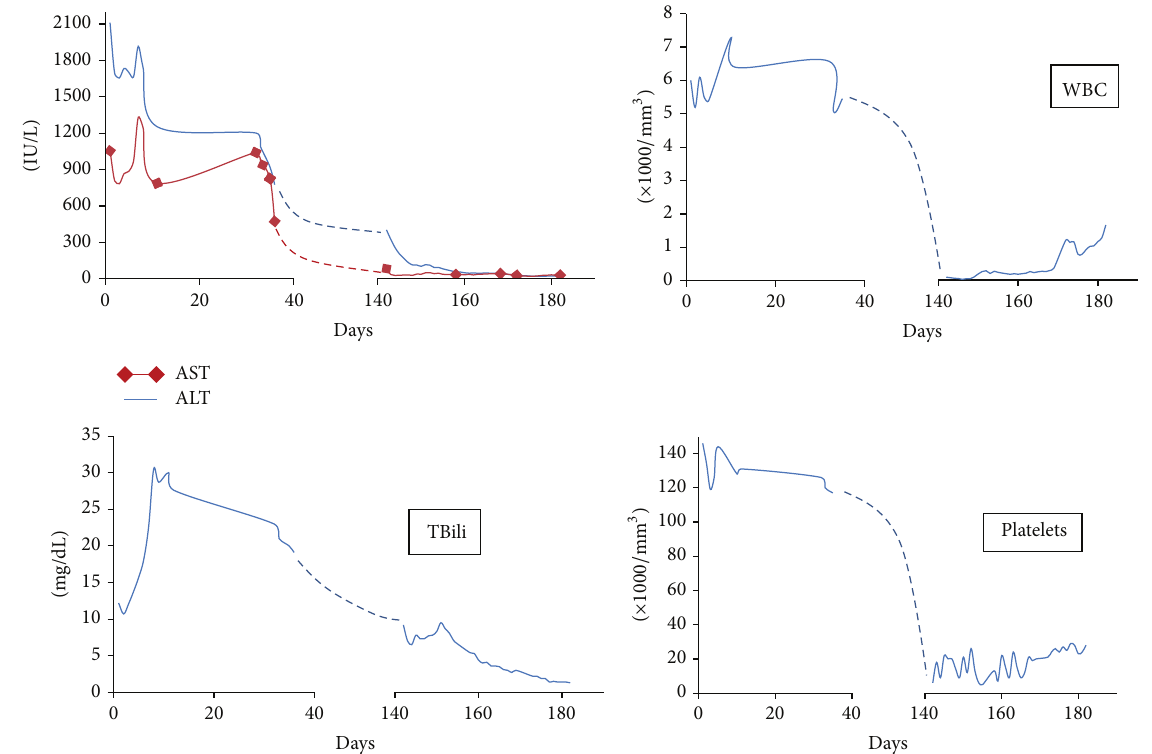
Figure 2: Graphical trends of the laboratory parameters of HAAA over six